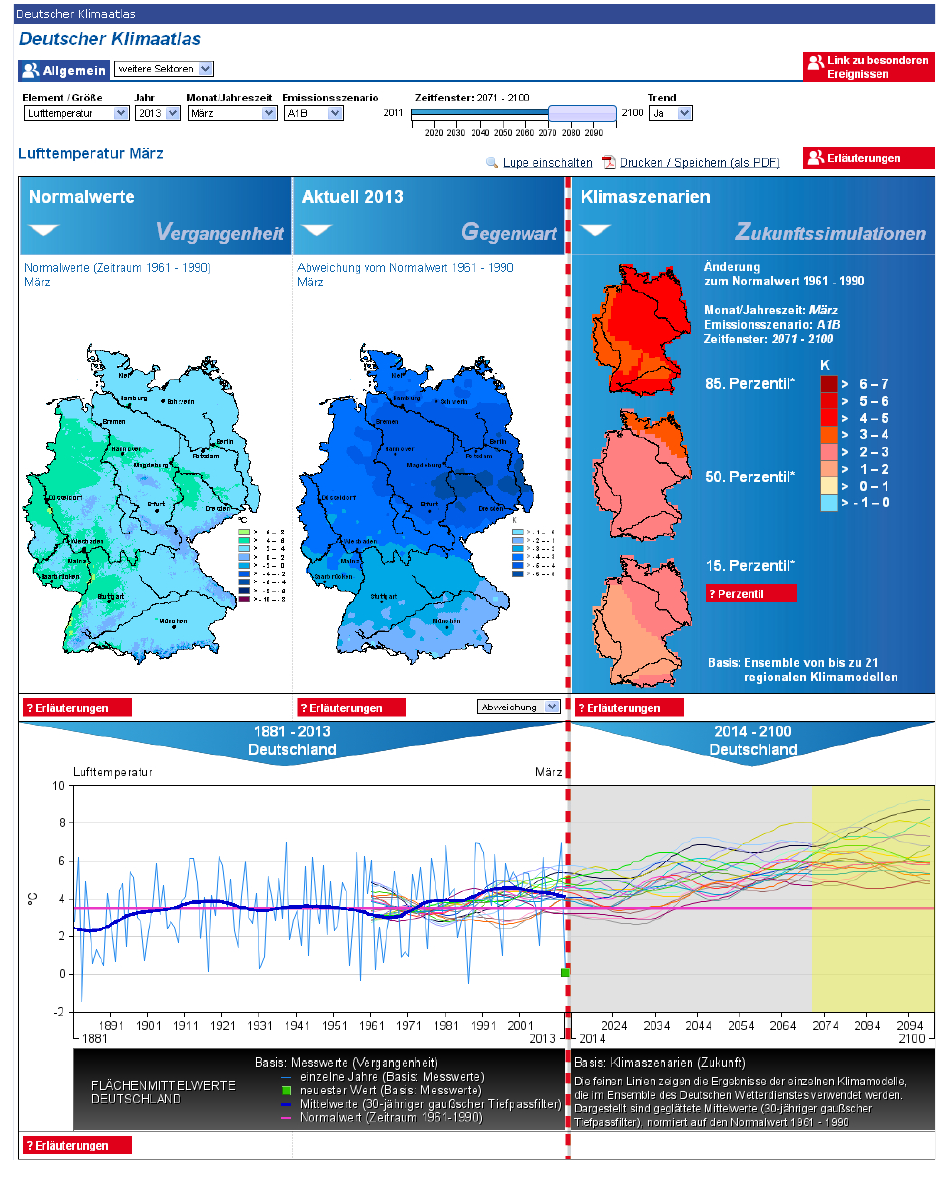
Figure 4. The German climate atlas provides a comprehensive overview of climate in Germany. Here, the parameter “temperature” of “March 2013” is selected (which was the 5th coldest since 1881). The left map shows the average values for March during the reference period 1961–1990. The middle map shows the anomaly in March 2013. The right maps show results of regional climate models (also for March; interval 2071–2100 is selected). At the bottom, the time series of March temperatures is shown. The observation-based information (black and pale blue; left part) can directly be compared with the climate projections (assorted colours;